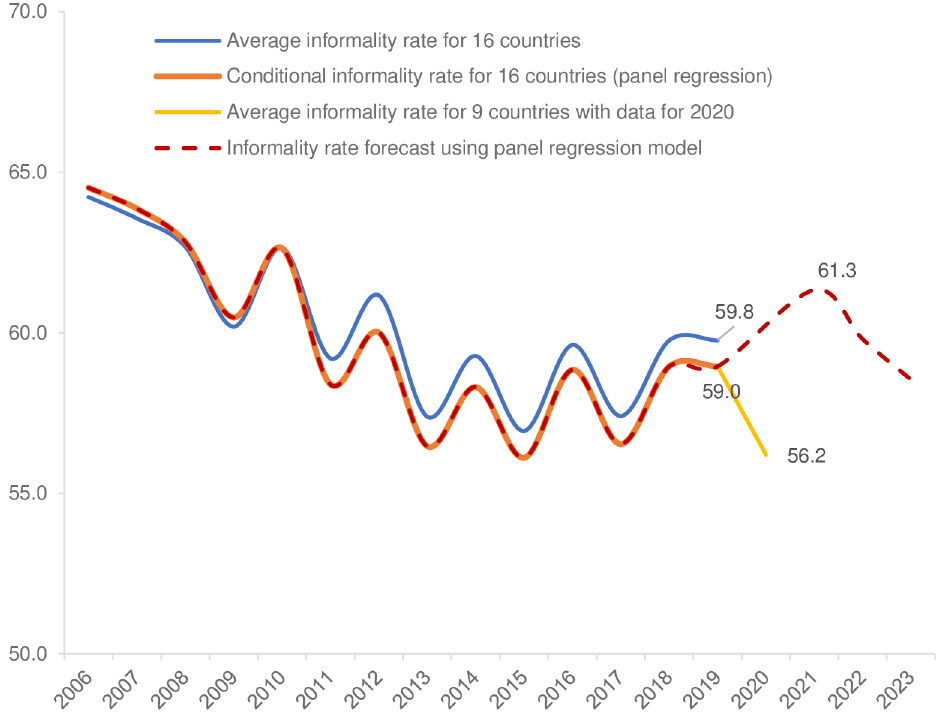
Fig 4. Latin America: Simulation of the informality rate (percent). Source: Estimates based on data from the World Bank’s World Development Indicators; the IDB’s Labor Markets and Social Security Information System (SIMS), 2020; and 2020 employment and household surveys for Argentina, Bolivia, Brazil, Chile, Colombia, Ecuador, Mexico, Paraguay, and Peru. The blue line represents the average informality rate in 16 countries (Argentina, Bolivia, Brazil, Chile, Colombia, Costa Rica, Dominican Republic, Ecuador, El Salvador, Guatemala, Honduras, Mexico, Panama, Paraguay, Peru, Uruguay; the red line is the informality rate predicted by the model in Eq (1); and the yellow line presents the drop in the informality rate between 2019 and 2020 in Argentina, Bolivia, Brazil, Chile, Colombia, Ecuador, Mexico, Paraguay and Peru.